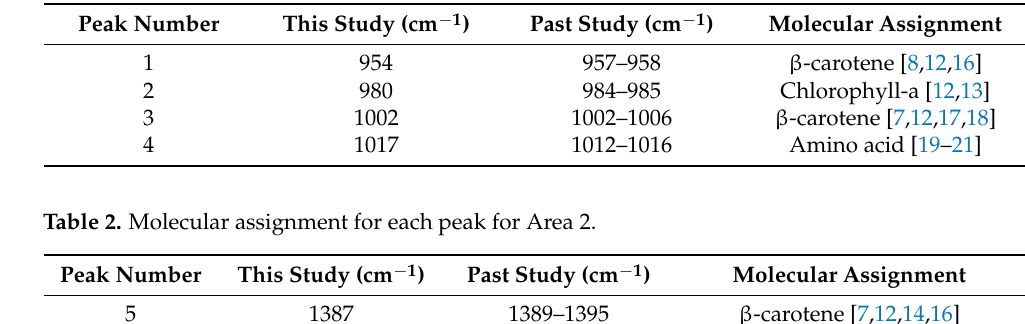
Figure 4. ( a ) Deconvolution results of left side of Area 2 with P5 (5th peak) and P6 (6th peak); ( b ) Deconvolution results of right side of Area 2 with P6 (6th peak) and P7 (7th peak) (1370 to 1460 cm −1 ). Table 1. Molecular assignment for each peak for Area 1.